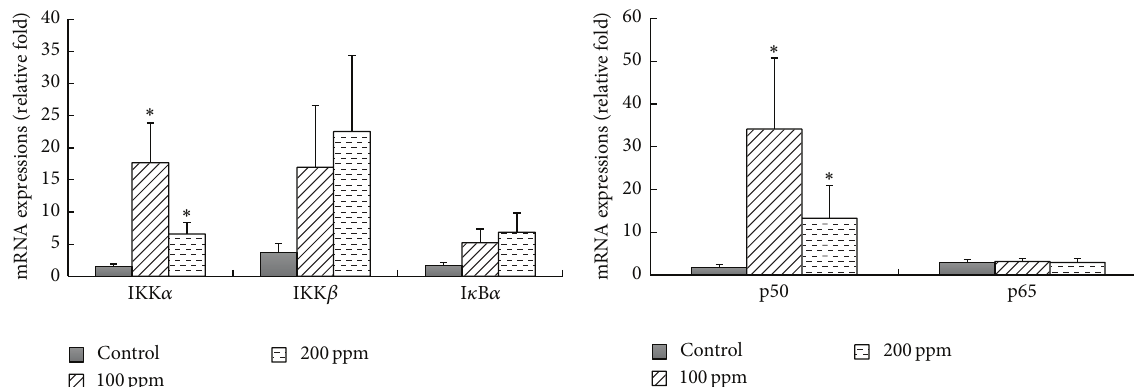
Figure 2: Effects of DMA V on the mRNA expressions of IKK 𝛼 , IKK 𝛽 , p65 , p50 , and I 𝜅 B 𝛼 of bladder epithelium in rats. IKK 𝛼 , IKK 𝛽 , p65 , p50 , and I 𝜅 B 𝛼 mRNA levels of bladder epithelium in rats were measured by qRT-PCR. Bars were presented as mean ± SD. ∗ 𝑝 < 0.05 compared to the control group.